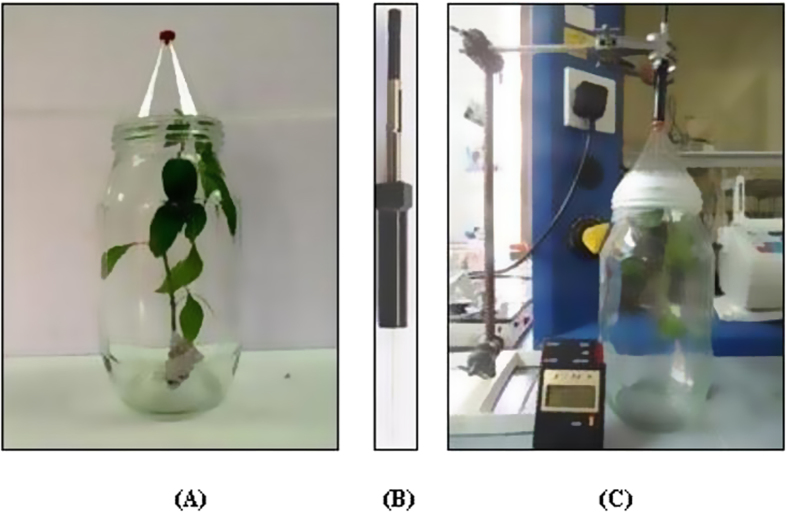
Static headspace sampling with (SPME) device.(A) The plant sample was enclosed in a glass container for 60 min, with a broad opening for easy removal of the plant. (B) The fiber is mounted on a SPME fiber holder. (C) The fiber was injected through the septum of the sample container by pushing the plunger of the SPME fiber holder, and extended from the needle and exposed to volatiles for 30 min. After collection VOCs, the fiber was retracted into the needle and the SPME device removed from the container for GC-MS analysis.